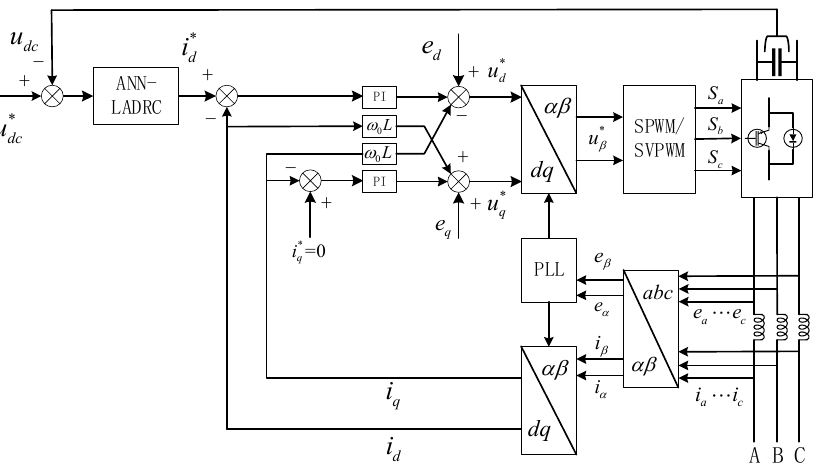
Figure 8. Overall control block diagram of the network-side inverter. The superscript * indicates the reference value.